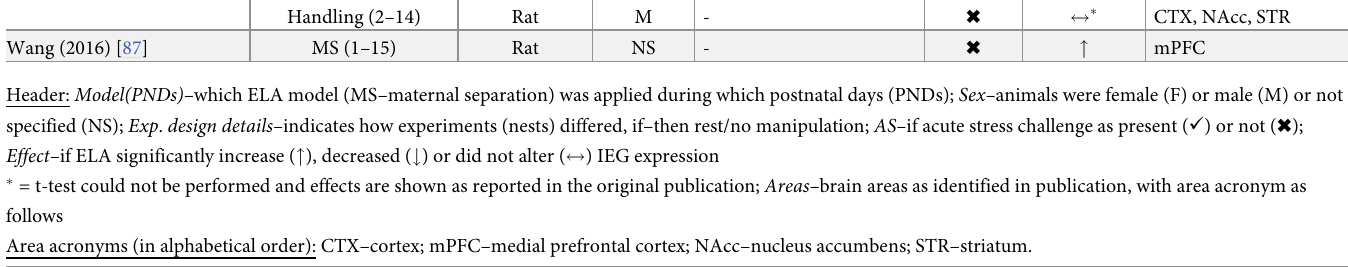
paring the effect size between control and ELA animals against 0). Lastly, we performed an exploratory analysis to investigate potential interactions with acute stressor severity on the